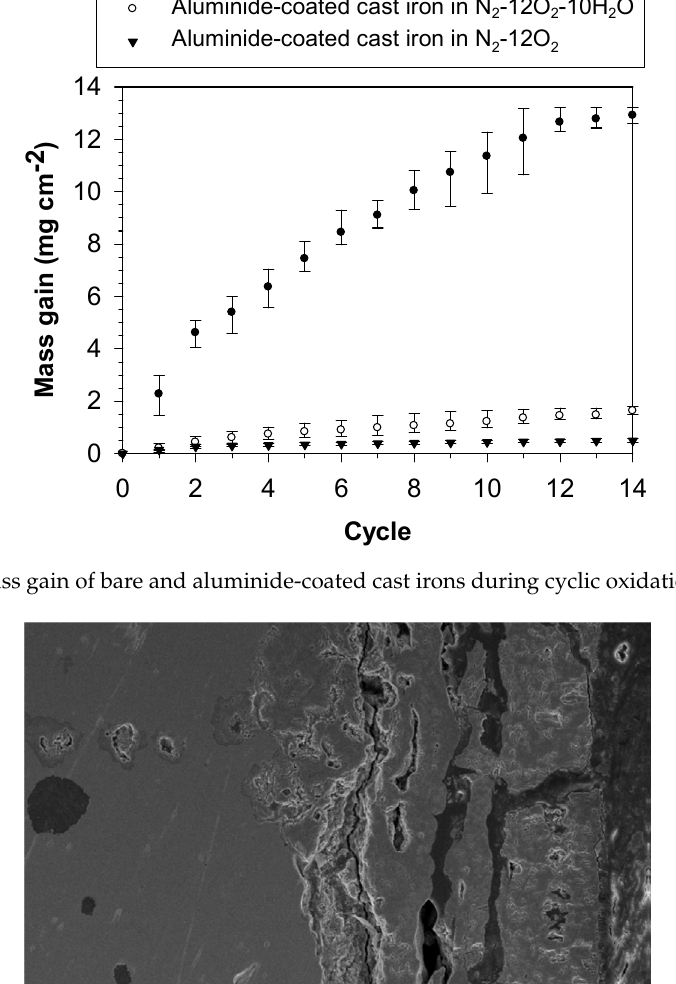
Figure 3. SEM cross-section of the bare cast iron after cyclic oxidation at 850 °C in N 2 –12O 2 –10H 2 O for 14